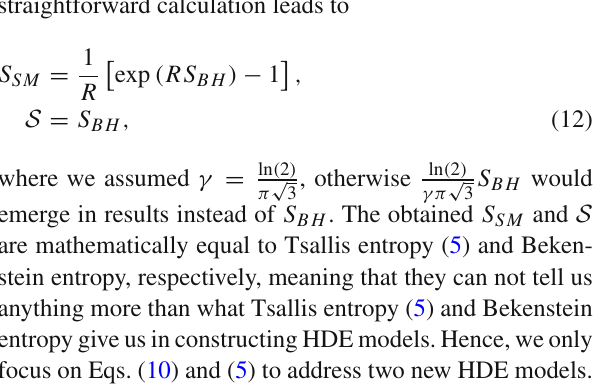
= 67 . 9 [48] m ), and H 0